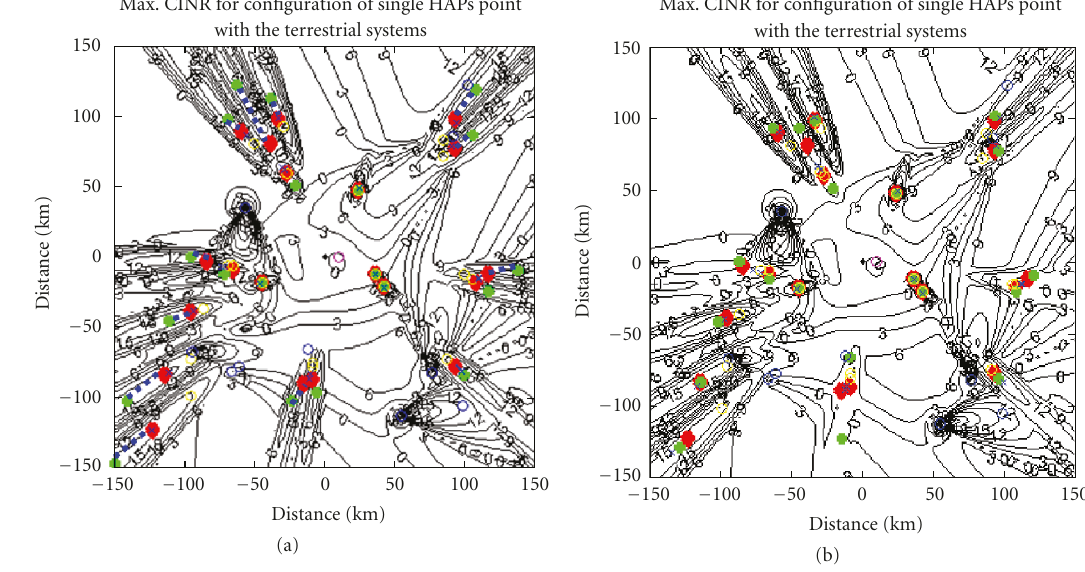
Figure 7: (a) Initial CINR contour plot of single HAP with multiple antenna beams with terrestrial systems. (b) Final CINR contour plot of single HAP with multiple antenna beams with terrestrial systems after applying Scheme I.